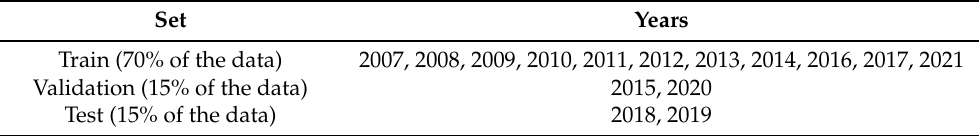
Table 2. Years distribution in the train, validation, and test set. The dataset is composed of 1985 images for the period